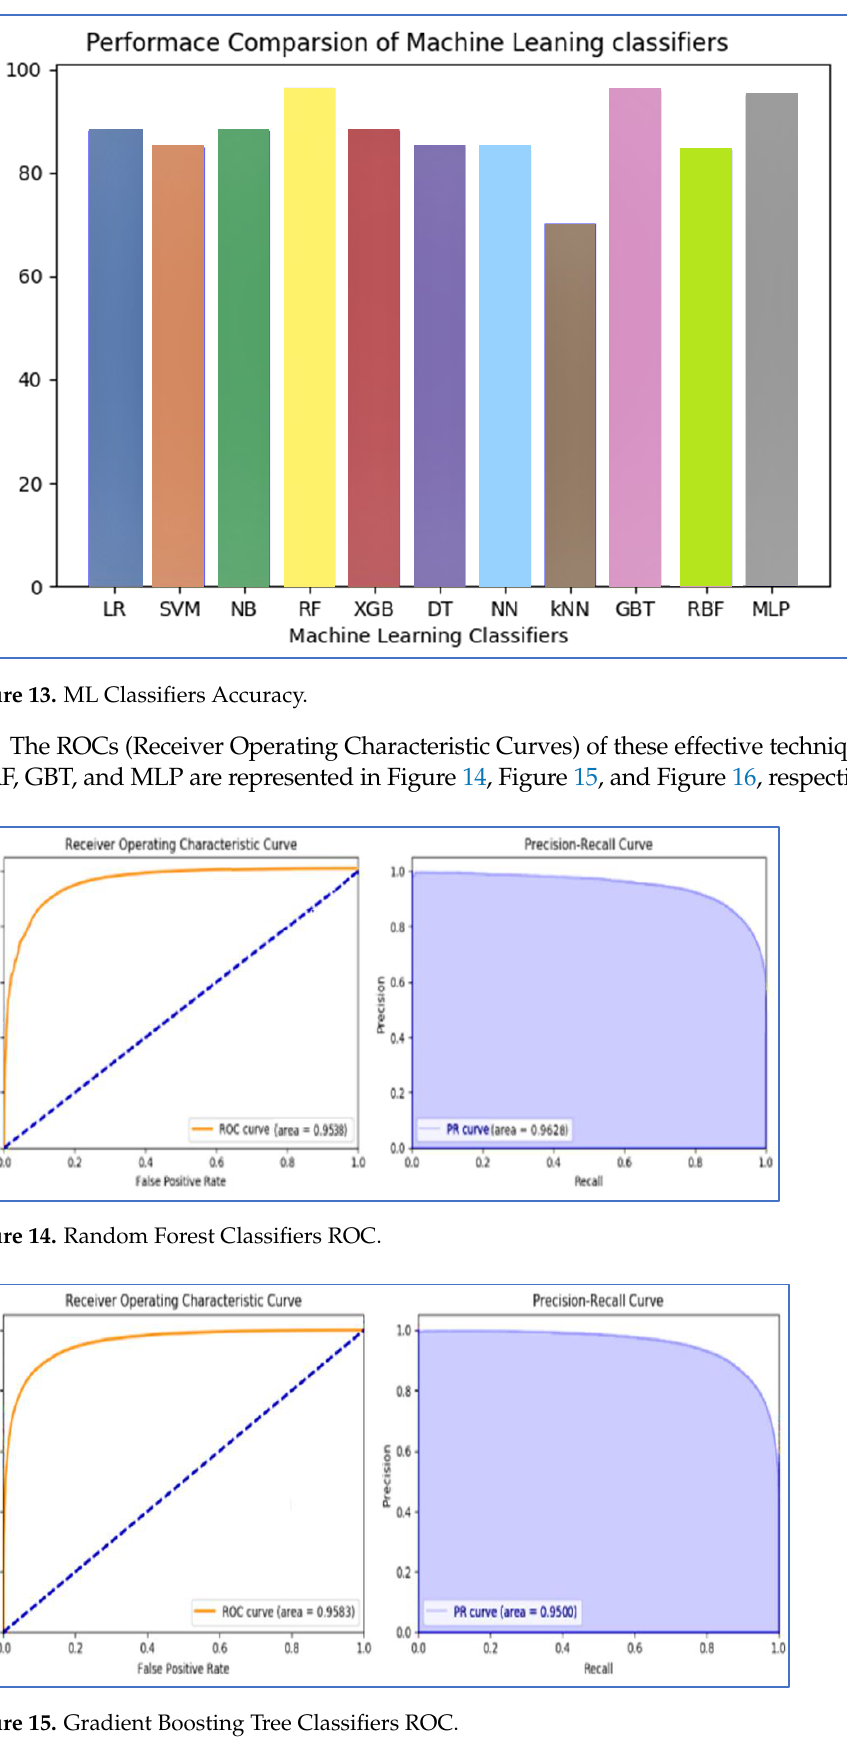
Figure 16. Multilayer perceptron Classifiers ROC. 6. Conclusions and Future Work In this paper, ML classifiers are used to predict the presence of heart problems. The dataset was attained from UCI repository. The gained data is cleansed, and preprocessing is performed. After that, ML models are applied for predicting. The potential of these eleven applied ML approaches for predicting cardiac disease was assessed. The inclusion criteria of these algorithms are to be state-of-the-art and representative and have high ma- turity. By comparing with existing work, we have used the Gradient Boosted Tree (GBT) and Multilayer Perceptron (MLP) earlier, but other researchers have not used them on the UCI heart disease dataset, and we have achieved more accuracy compared to them, as